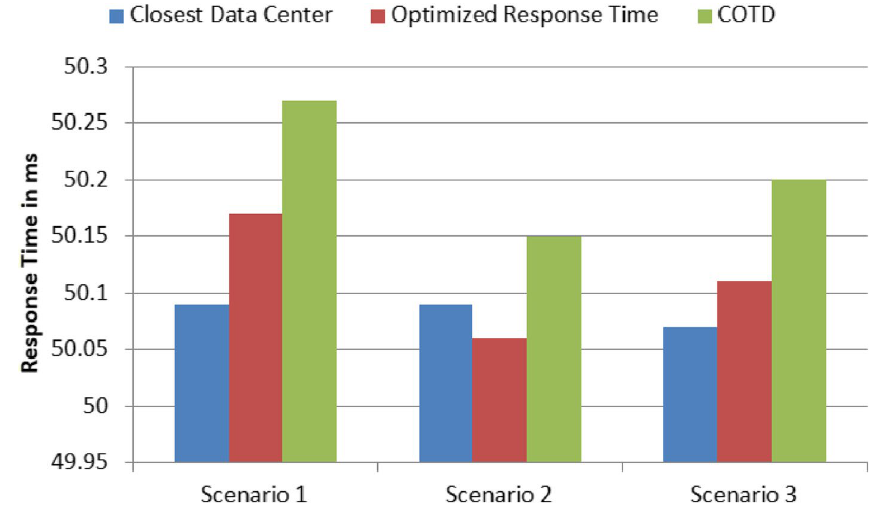
Fig. 8 Response Time comparison of three scenarios